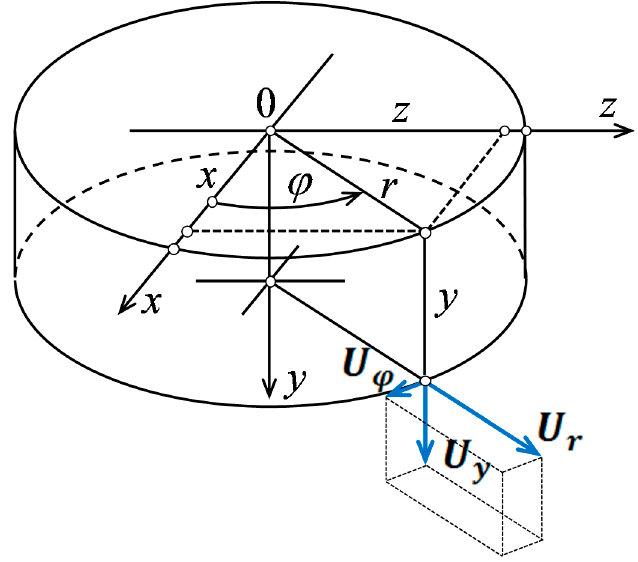
Figure 2. Cylindrical coordinate system. The origin of the coordinate system is located in the center of the diffuser on the ceiling level.